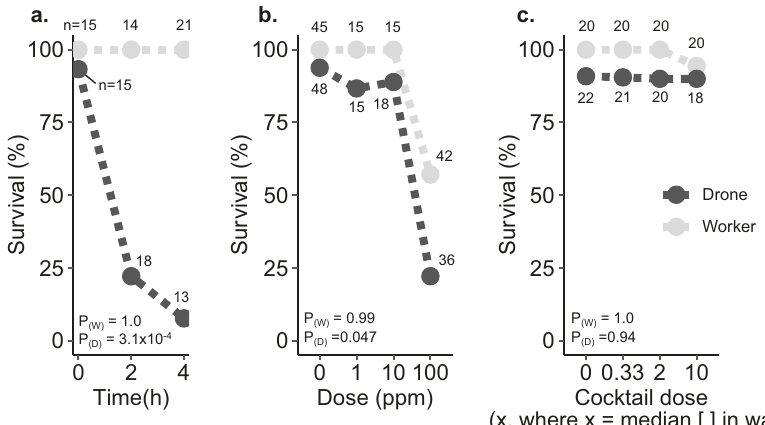
Fig. 1 Sex biases in survival during temperature and pesticide stress challenges. Drones and workers (all fi ve days old at the beginning of the experiment) from three different colony sources were paint marked and kept in California-style queen shipping cages with candy (one subject with fi ve other companion workers in each cage). Statistical differences were evaluated using a generalized linear model on survival count data with a binomial distribution. Sample sizes for each group are indicated in the fi gure. Baseline survival rates are indicated by the negative control group (2 µ l topical acetone treatment for ‘ cocktail ’ and ‘ imidacloprid ’ groups, and room temperature incubation for the ‘ cold ’ group) after two days. a Survival of drones and workers two days after exposure to different durations of cold stress (4 °C), b topical exposure to different concentrations of imidacloprid, and c topical exposure to different concentrations of a pesticide cocktail of compounds commonly found in wax (see McAfee et al. 29 for the recipe, and Traynor et al. 24 for the supporting data). See Supplementary Data 1 for underlying